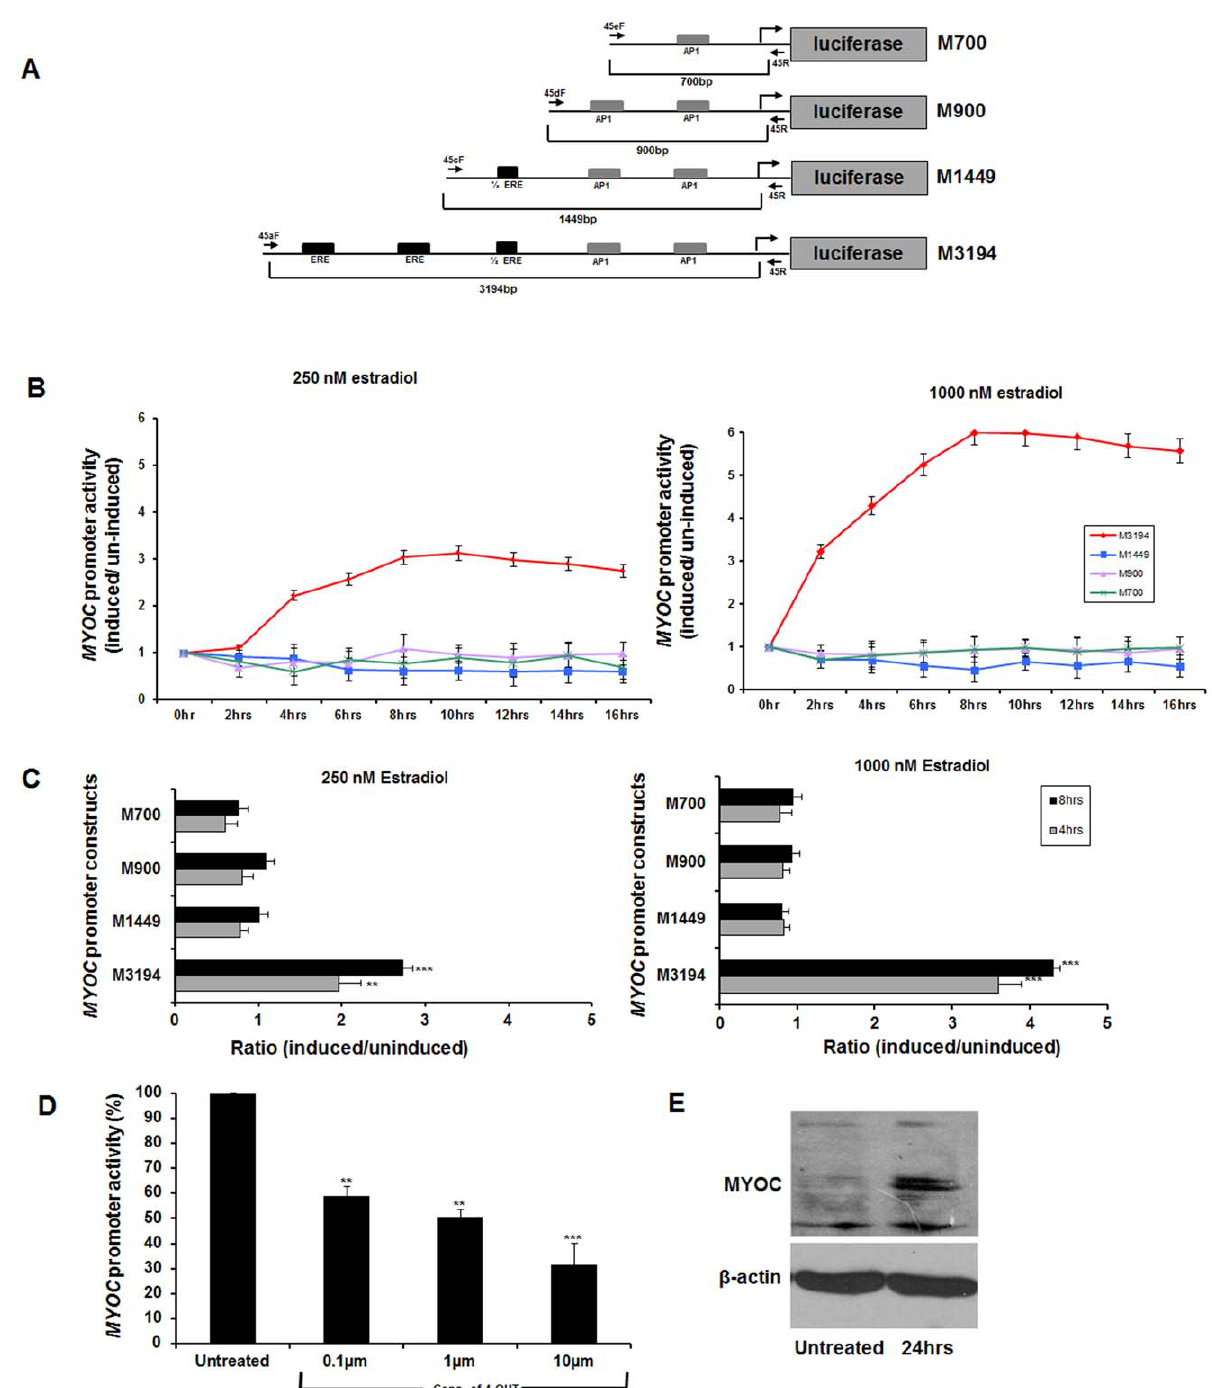
Figure 3. Functional evaluation of putative EREs in MYOC promoter. A : Serial constructs of MYOC -promoter region containing ERE and AP1 sites cloned in promoter less PGL3 basic vector. Black solid arrows indicate the forward and reverse primers used to amplify the inserts for subcloning. Also, the alphanumeric nomenclature of the constructs corresponds to the first initial of myocilin (M) followed by the size of the insert in base pairs. B : Luciferase activity in extracts from RPE cells transfected with the clones containing MYOC constructs and treated with 17 b estradiol (250 nM or 1000 nM). C : Ratio of luciferase activity in cell extracts between induced and uninduced RPE cells for all 4 serial constructs upon dose (250 nM and 1000 nM) and time (4 hrs & 8 hrs) dependent treatment of 17 b estradiol. The time points were taken based on the previous experiment in Panel B . D : The M3194 construct was transfected in RPE cells and subjected to increasing amount of 4-hydroxy tamoxifen (4-OHT; 17 b estradiol competitor) treatment followed by luciferase assay. A gradual decrease in MYOC promoter activity was observed with increasing amount of 4-OHT. E : Significant upregulation of endogenous myocilin with 17 b estradiol treatment in HTM cell. (**p-value , 0.001, ***p-value , 0.0001). Three independent replicates were performed for all the experiments described here.